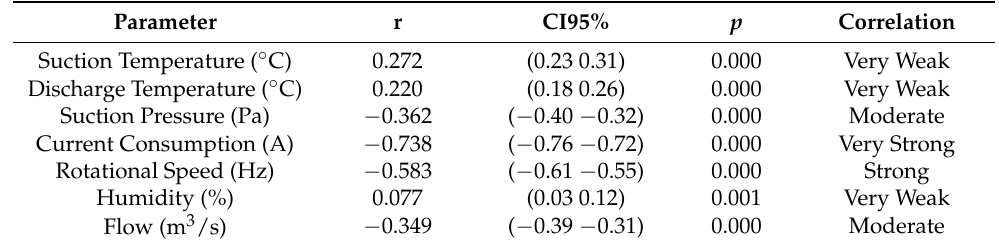
Table 1. Correlations (Pearson) between the measured parameters and the fan efficiency. Parameter r CI95% p Correlation Suction Temperature ( ◦ C) 0.272 (0.23 0.31) 0.000 Very